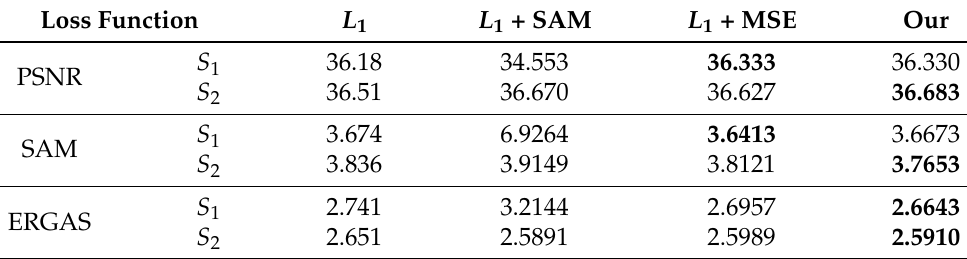
Table 8. Effects of different loss functions